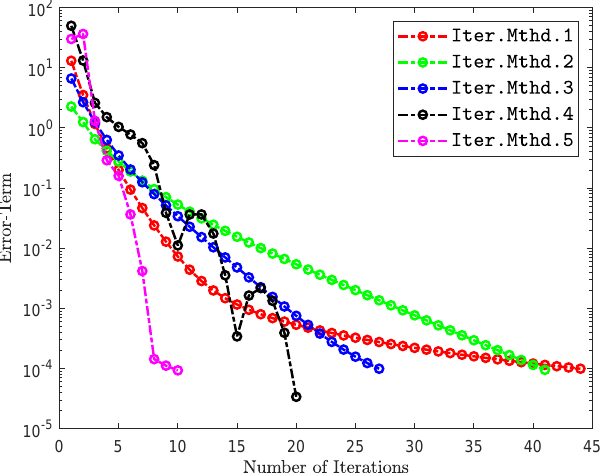
Figure 7. All techniques are computationally examined while s 0 = ( 2, − 2,3, − 4,6 ) T